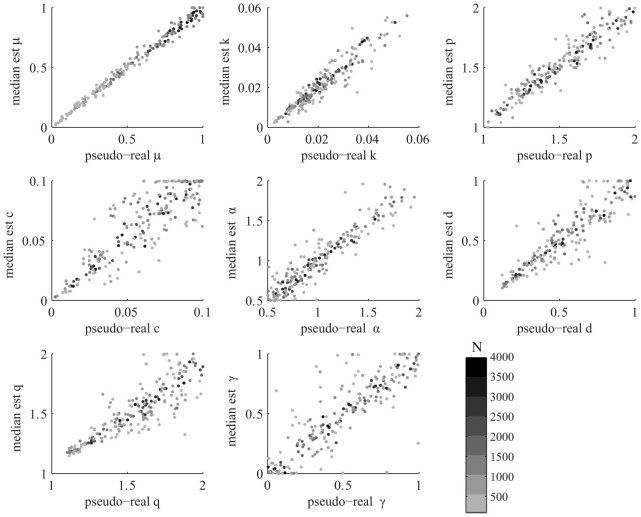
Plot of median estimates  versus the pseudo-real values  for the 8 parameters of the ETAS model {μ, k, p, c, α, d, q, γ} and for all the simulated catalogs.The color is scaled with the size of the catalog (see text for details).